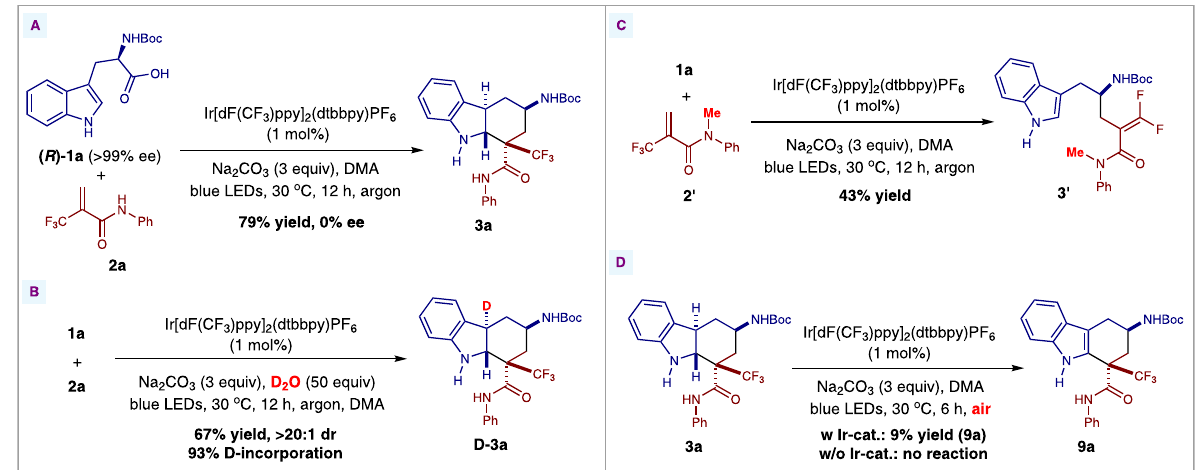
Fig. 6 Mechanistic experiments. A Reaction of enantiopure ( R )- N -Boc-tryptophan ( R )- 1a with substrate 2a . B Deuterium experiment. C Reaction of N - methyl substituted acrylamide 2' with substrate 1a . D Control experiments.